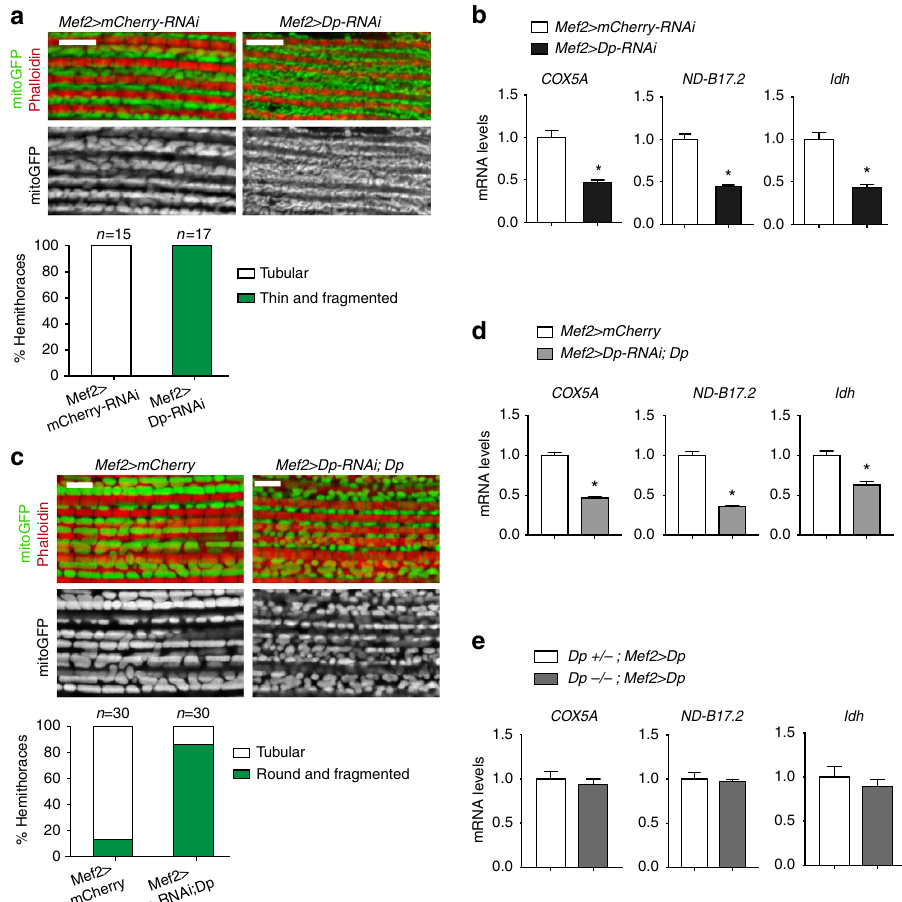
Figure 6 | Mitochondria are abnormal in Dp-depleted muscles. The structure of mitochondria ( a ) and the expression of nuclear-encoded mitochondrial genes ( b ) are compromised in Dp-depleted muscles at the pharate stage. Although mitochondrial structure ( c ) and gene expression ( d ) are not fully reversed in the partially rescued adult flies (2- to 5-day-old), gene expression is fully restored in the rescued pharates that express Dp in Dp -mutant background ( e ). ( a , c ) Confocal images of DLMs stained with Phalloidin (red) and mitoGFP (green) to label mitochondria in a sagittal view. Scale bar, 5 m m. Quantification of hemithoraces displaying ( a ) round/tubular or thin/fragmented mitochondria shape, N ¼ 15 and 17 hemithoraces per genotype, ( c ) tubular or round/fragmented mitochondria shape, n ¼ 30 hemithoraces per genotype. Two independent experiments were performed. ( b , d , e ) The expression of the nuclear-encoded mitochondrial genes Cytochrome c oxidase subunit 5A ( Cox5A , also known as CoVa ), NADH dehydrogenase ( ubiquinone ) B17.2 subunit ( ND- B17.2 , CG3214 ) and Isocitrate dehydrogenase ( Idh , CG6439 ), quantified using RT–qPCR in indirect flight muscles of pharate pupae ( b , e ) and adult flies ( d ). Mean ± s.e.m., N ¼ 3 independent samples per genotype, Mann–Whitney test, * P o 0.05. Genotypes are ( a , b ) Mef2-GAL4/UAS-mCherry-RNAi (left panel and white bar) and UAS-Dp-RNAi;Mef2-GAL4 (right panel and black bar), ( c , d ) Mef2-GAL4/UAS-mCherry (left panel and white bar) and UAS-Dp-RNAi;Mef2- GAL4/UAS-Dp (right panel and grey bar), and ( e ) Dp a3 / þ ; Mef2-GAL4/UAS-Dp (white bar) and Dp a3 / Df(2R)Exel7124;Mef2-GAL4/UAS-Dp (grey bar).